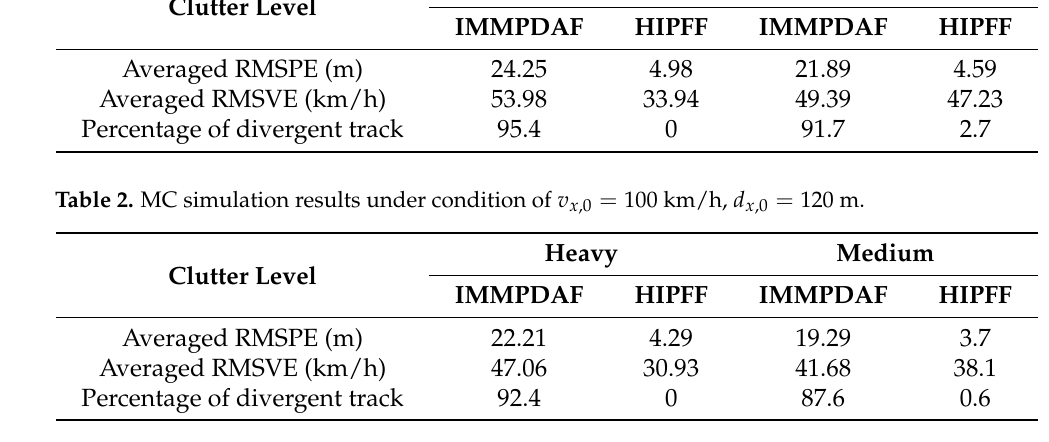
Table 1. Monte Carlo (MC) simulation results under the condition of v x ,0 = 120 km/h, d x ,0 = 140 m. Clutter Level